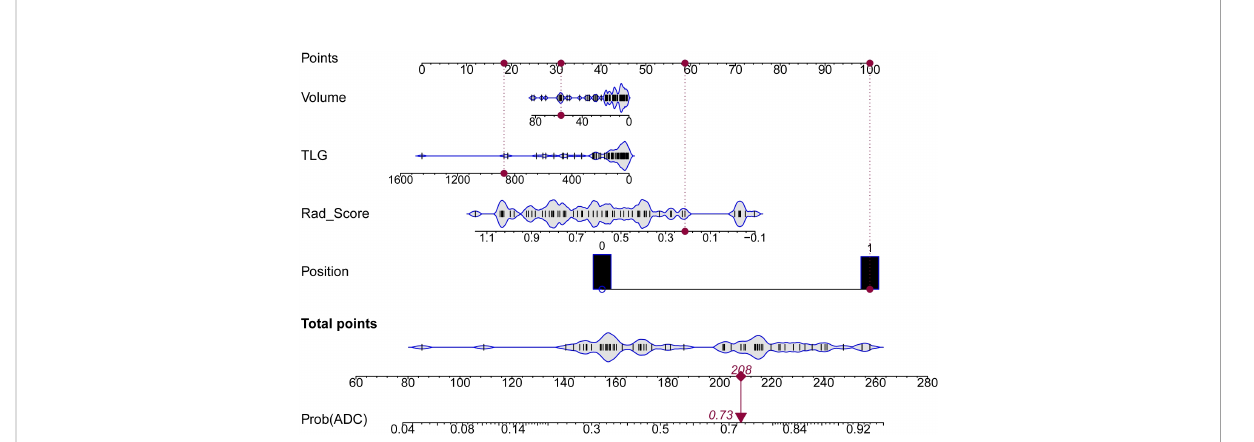
FIGURE 4 Nomogram for predicting the risk probability of ADC. Four variables were included in the nomogram model. For a given sample, each variable had a point, and the total point re fl ected the probability of